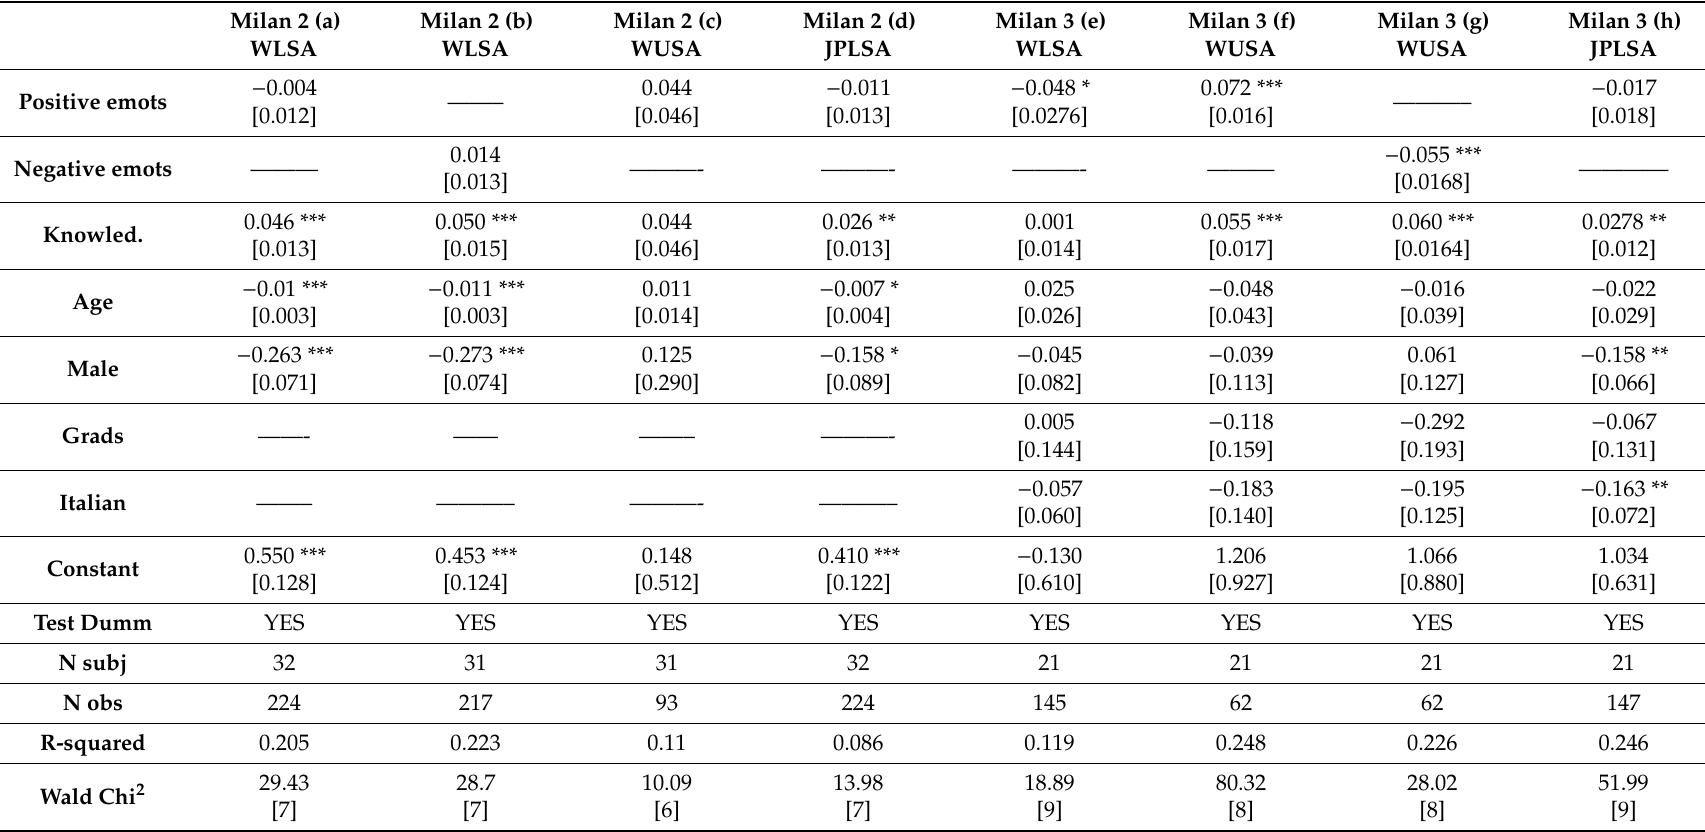
Table 6. Bounded Subadditivity Test: Milan 2 and Milan